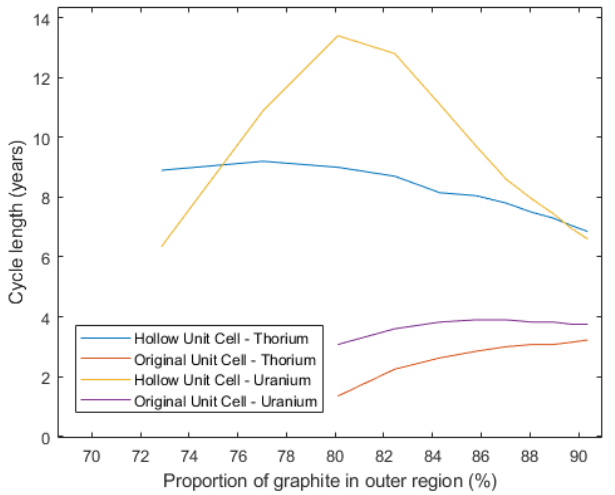
Figure 4: Maximum cycle length at various outer graphite proportions with uranium or thorium